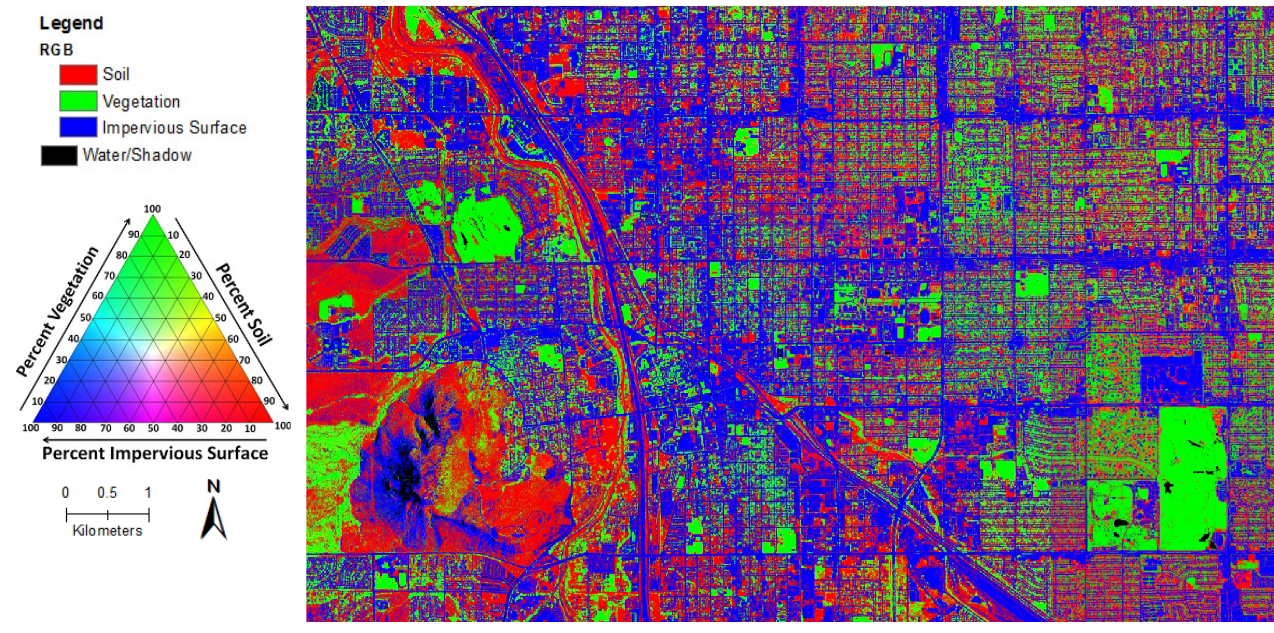
Figure 7. V-I-S model showing percent cover type based on aggregating the 1m CART classification results to 10 m pixels. Water and shadow are masked in this visualization of multiple attributes that affect mosquito